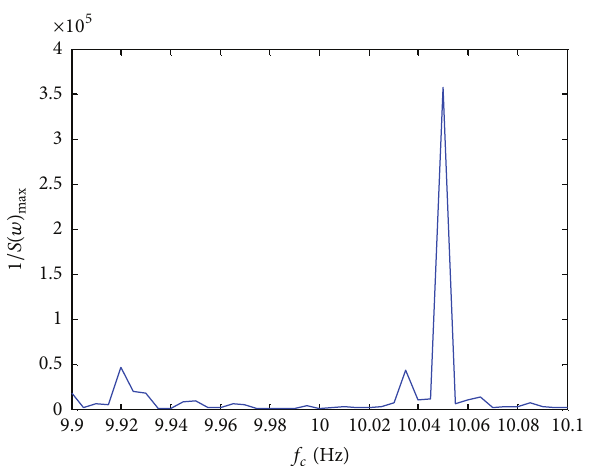
Figure 8: The change curve about the reciprocal of the stochastic resonance output signal spectrum peak with the adjustment of 𝑓 𝑐 in the single high frequency.